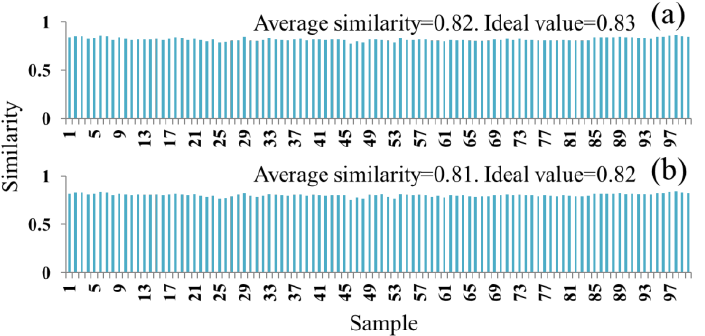
Figure 10. The registration similarity of the hybrid transformed images. ( a ) Translation and rotation; ( b ) scaling, translation, and rotation.